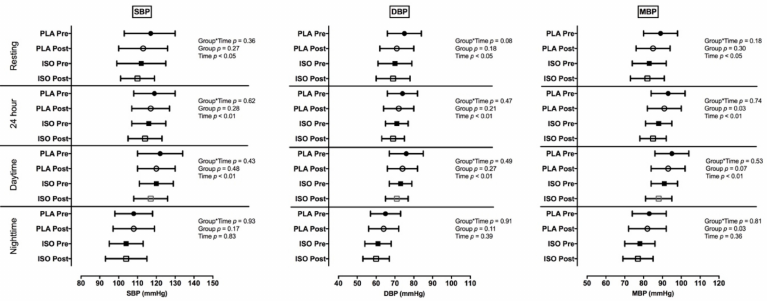
Figure 2. Intention-to-treat analysis of resting and ambulatory blood bressure monitoring AMBP results during 24 h, night-time and daytime periods (mean ± SD). PLA: placebo and exercise group; ISO: isoflavone and exercise group; SBP: systolic blood pressure; DBP: diastolic blood pressure; MBP: mean blood pressure; Pre: Measures pre interventions; Post: Measures post interventions.